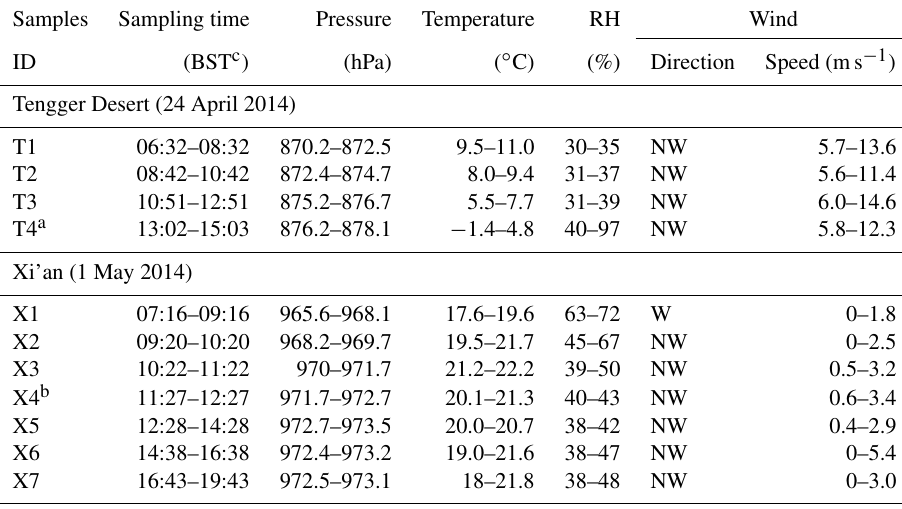
Table 1. Summary of weather conditions during the sample collection.